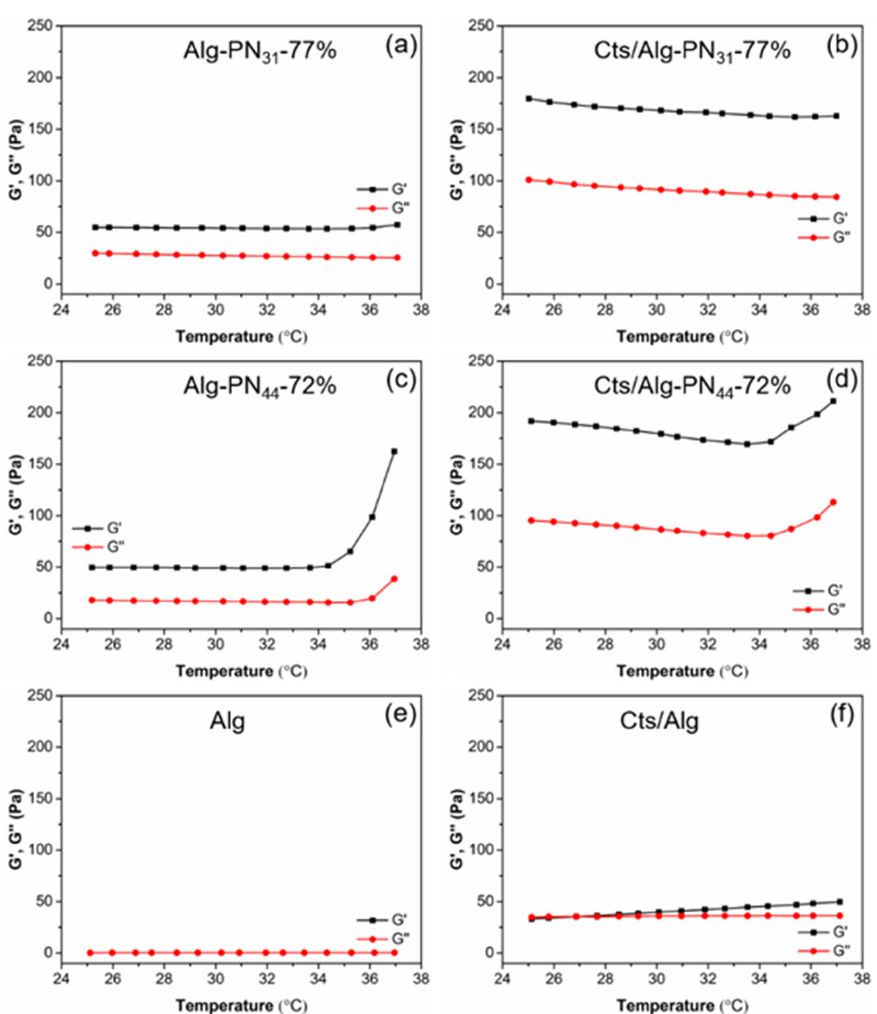
Figure 3. Elastic modulus (G ′ ) and viscous modulus (G ″ ) for Alg-PN 31 -77% ( a ), Cts/Alg-PN 31 -77% ( b ), Alg-PN 44 -72% ( c ), Cts/Alg-PN 44 -72% ( d ), Alg ( e ), and Cts/Alg ( f ) measured with a constant frequency (1.0 Hz) and fixed stress (1.0 Pa) at the plate temperature increasing from 25 to 37 °C at a rate of 0.05 °C/s.